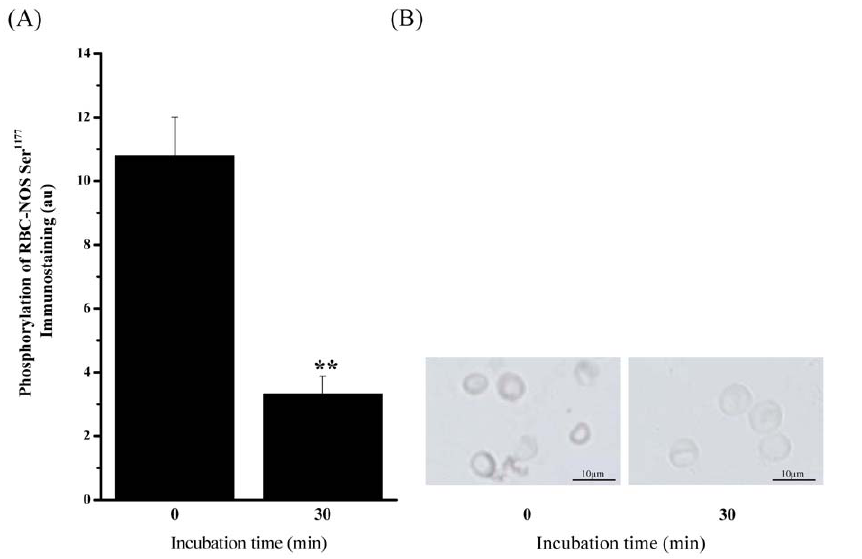
Figure 4. Change in RBC-NOSSer 1177 after PI3 kinase inhibition via wortmannin determined by immunohistochemistry. (A) Bars show statistical analysis of gray values (au) before (0 min) and after a 30 min incubation of whole blood with PI3 kinase inhibitor wortmannin (c=10 m M). RBC-NOSSer 1177 -signal significantly decreased after wortmannin incubation ( P , 0.01). (B) Pictures show representative RBC-NOSSer 1177 staining before and after the test, respectively. Data in (A) is presented as mean 6 S.E.M of n=6.